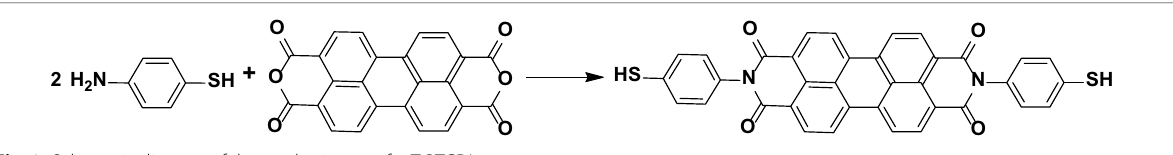
Fig. 2 Schematic diagram of the synthetic route for